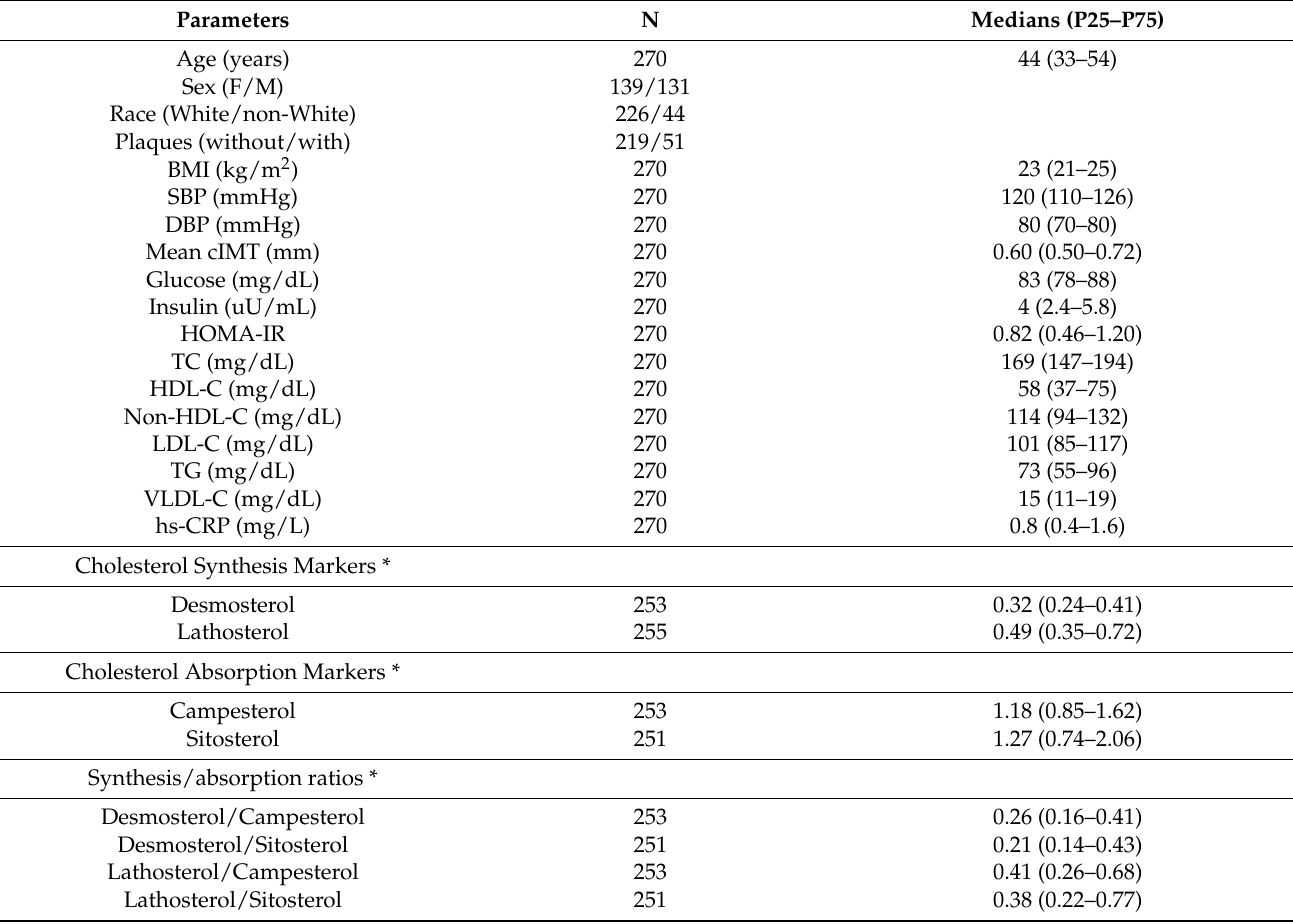
Table 1. Clinical, anthropometrical, and biochemical characteristics of all